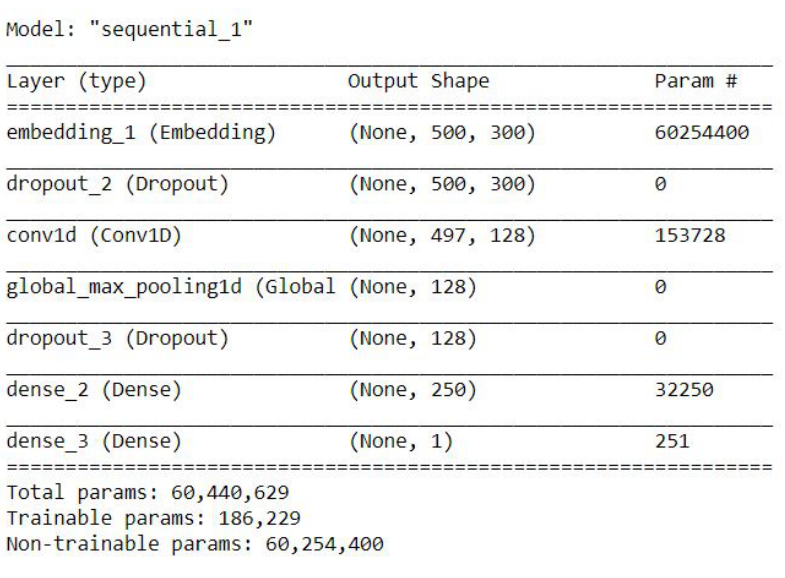
Figure 5. CNN with GlobalMaxpool Model.